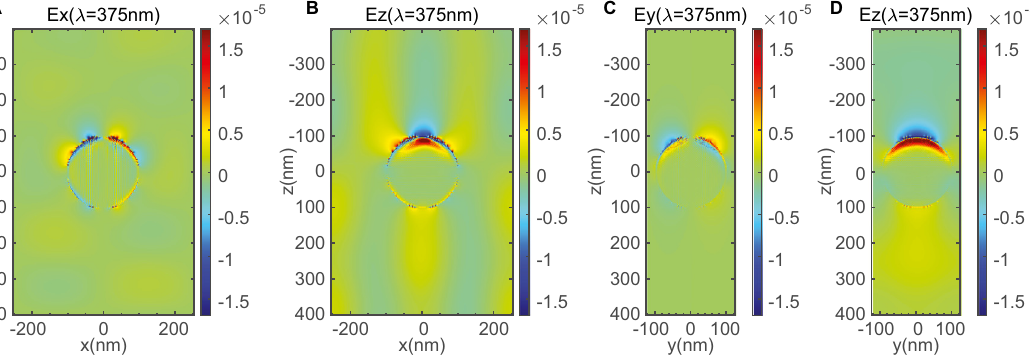
Figure5: (Coloronline)Thegeneratedsecondharmonicelectricfieldcomponent(A) E x and(B) E z inthe xz -plane,andcomponents(C) E y and(D) E z in the yz -plane cut through the nanoparticle center. The fi eld amplitude is normalized to the fundamental incident fi eld.